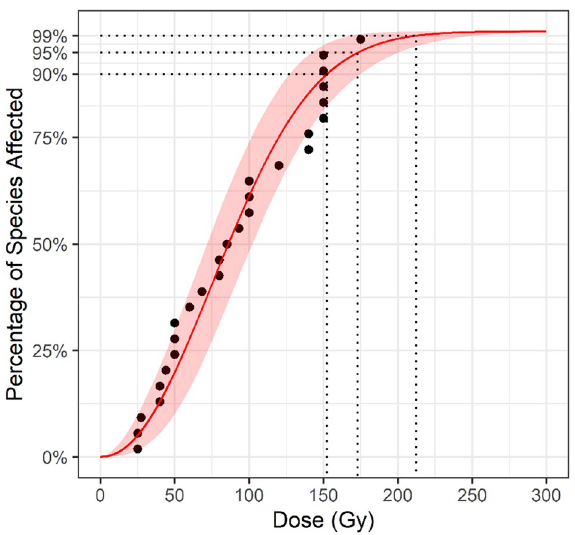
Figure 1. SSD Curve for Curculionidae fitted to the Weibull distribution with the shaded area covering the 5–95% confidence interval.